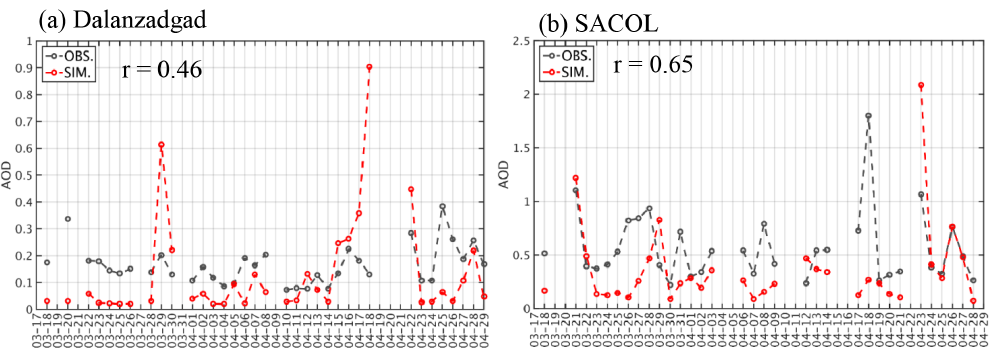
Figure 4. Time series of daily mean observed and simulated aerosol optical depths at Dalanzadgad (a) and SACOL (b) ; r represents the correlation coefficient between simulation results and